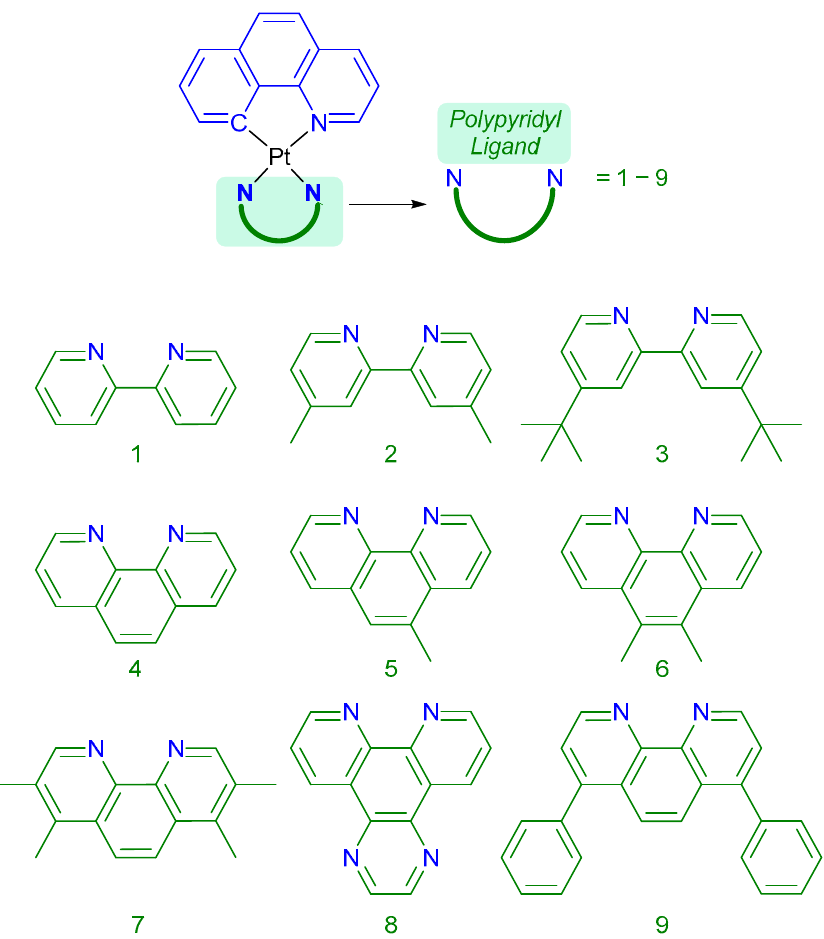
Figure 2. Structure of polyromantic ligands of all CMCs, coordinated as shown in the general structure outlined in Figure 1 to achieve: 1 [Pt(Bequ)(BPY)] + , 2 [Pt(Bequ)(44BPY)] + , 3 [Pt(Bequ)(tertBPY)] + , 4 [Pt(Bequ)(PHEN)] + , 5 [Pt(Bequ)(5MePHEN)] + , 6 [Pt(Bequ)(56Me 2 PHEN)] + , 7 [Pt(Bequ)(TMP)] + , 8 [Pt(Bequ)(DPQ)] + and, 9 [Pt(Bequ)(BathoPHEN)] + . All complexes have chloride counterions.